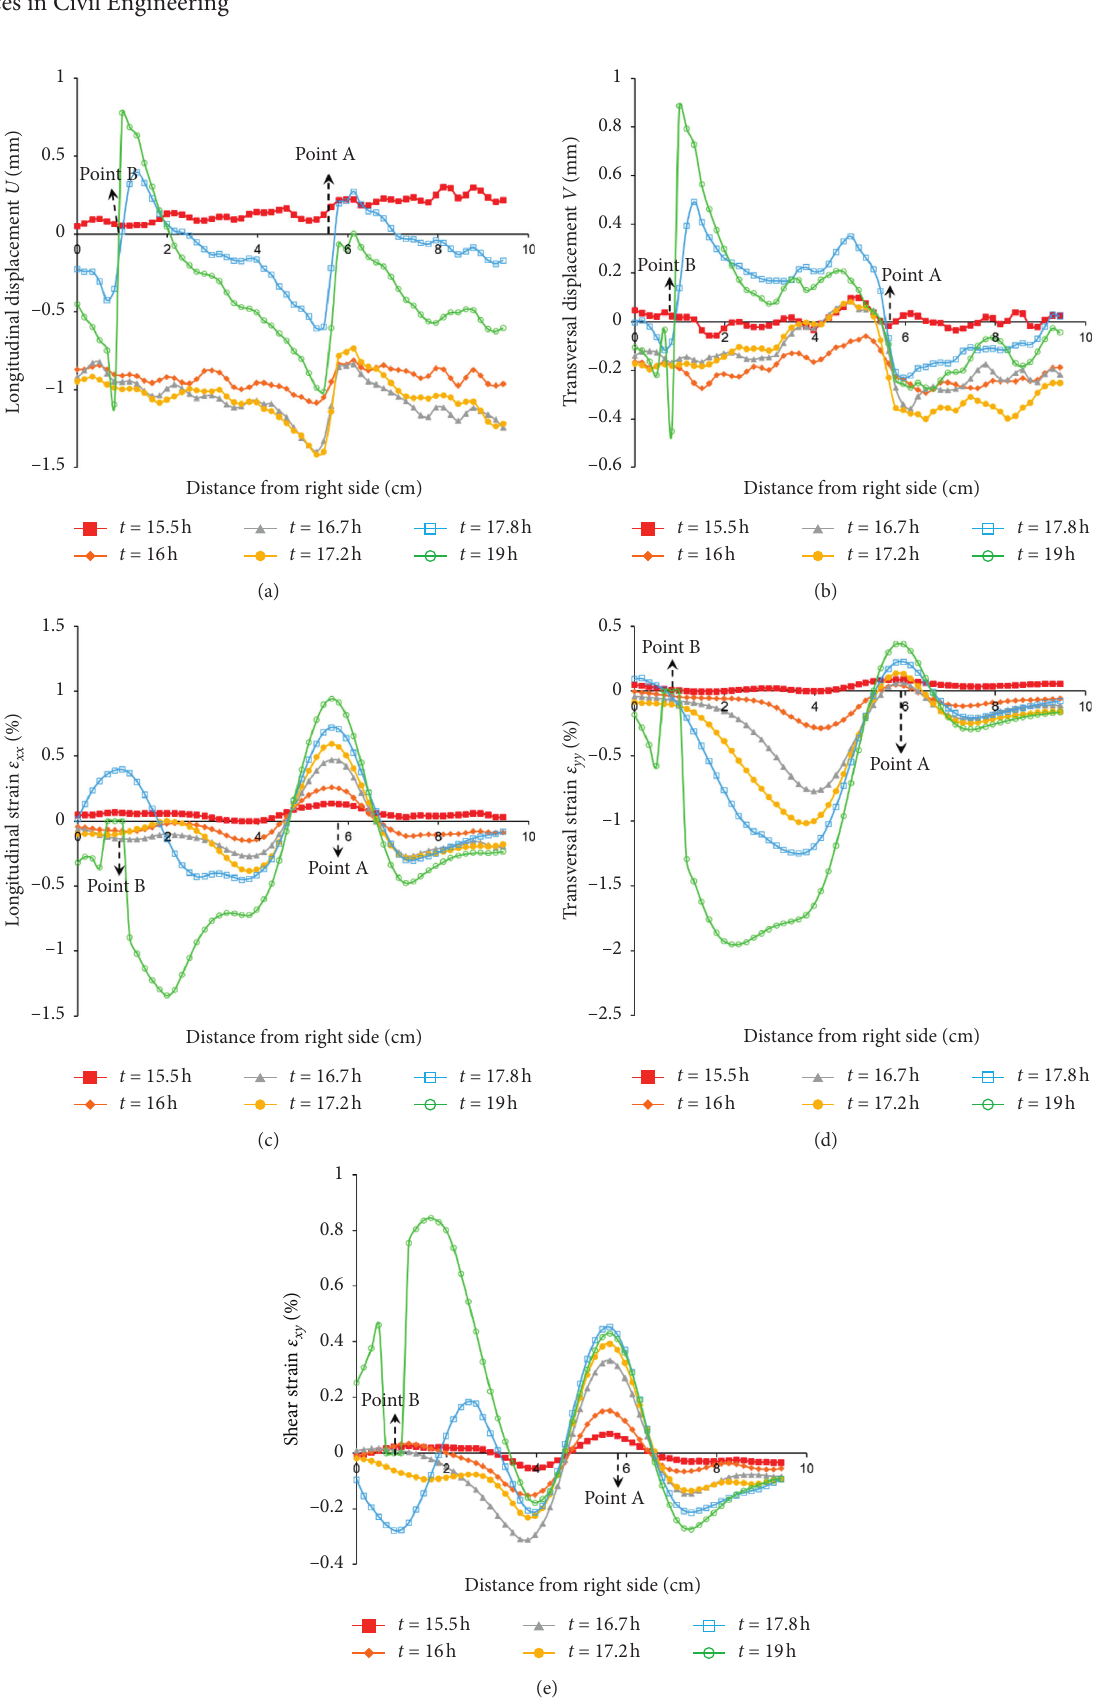
U ; (b) transversal displacement V ; (c)